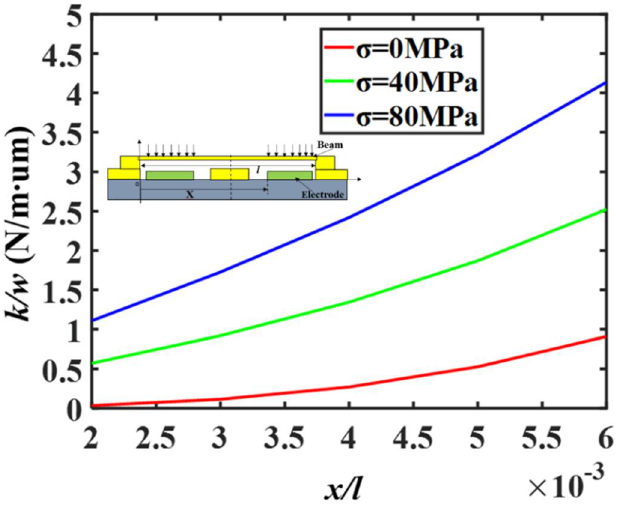
Figure 12. Relationship between elastic coefficient and residual stress. C u , C d , L and R can be extracted from the isolation S 12 . The RF MEMS switch and CPW transmission line consist of five parts and can be expressed by the ABCD matrix [19]: